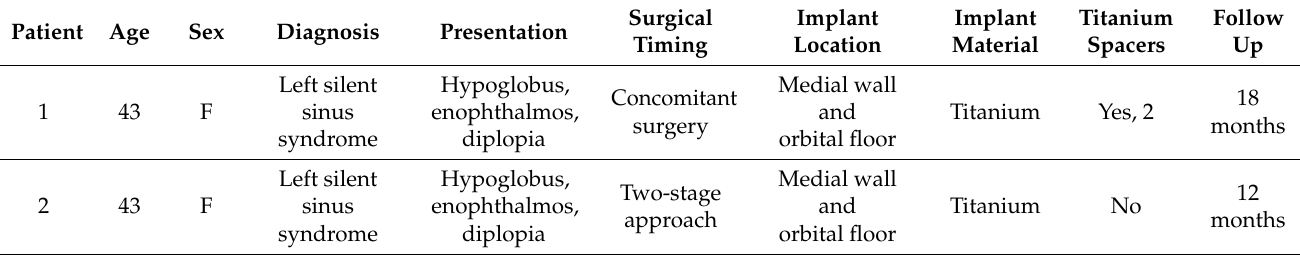
Table 1. Patients’ details and